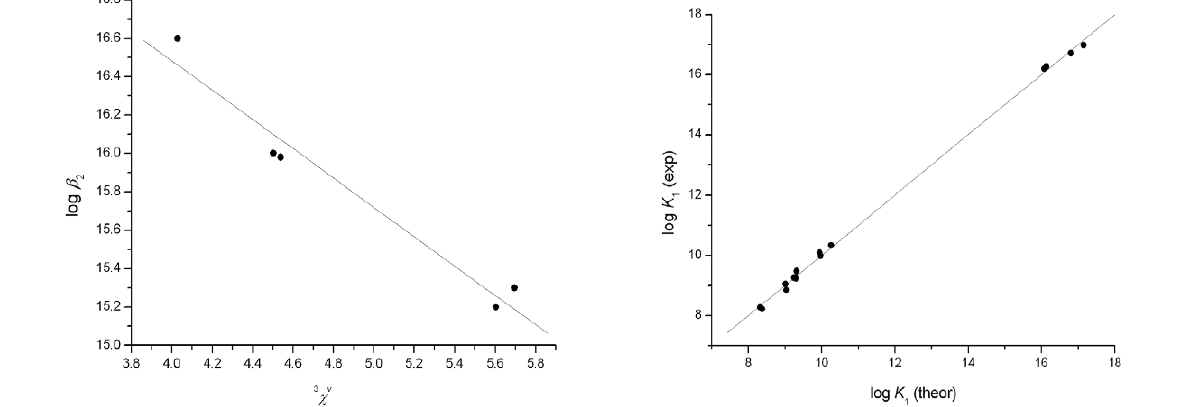
Figure 6. Experimental vs. theoretical (Eq. 4) log K Ni(II), Cu(II) and Zn(II) mono -complexes with salicylidene amino acids (Model 6, Table